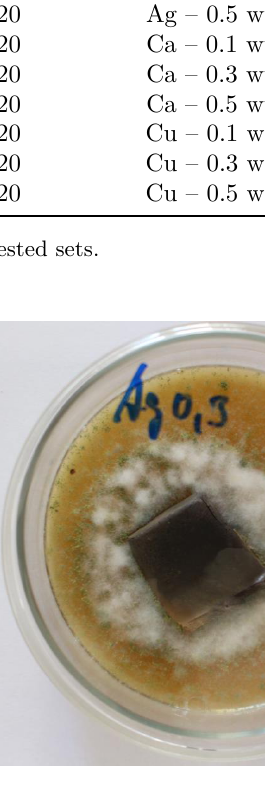
Figure 1. Image from electron microscope, BSE de- tector, magnified 400 . ×